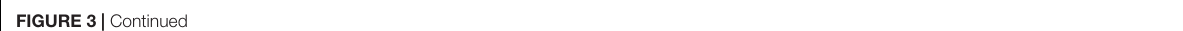
cortex versus 2.2 h in Pax6 − / − cortex, G2 phase was 1.3 h